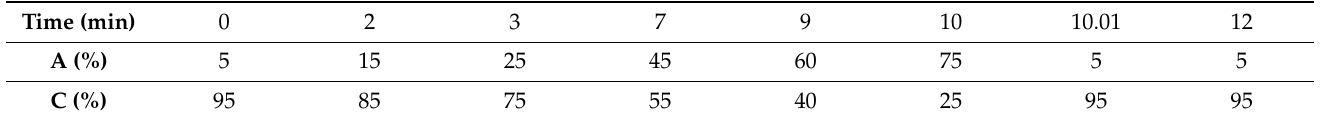
Table 3. The elution gradient of UHPLC-Q-Exactive